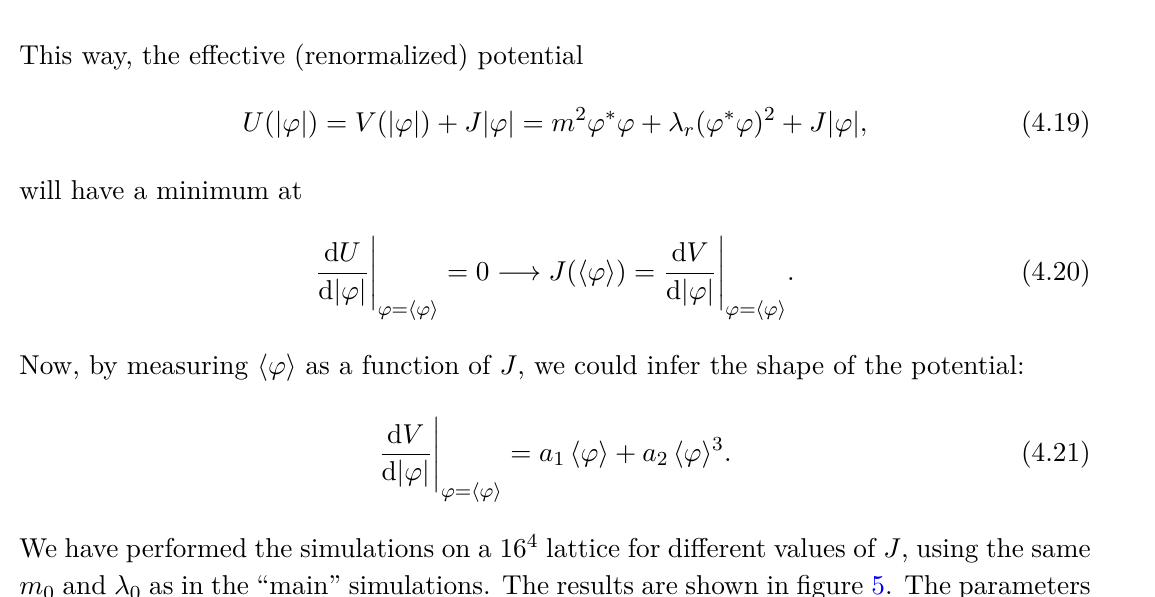
Table 1. Summary of simulations used in this work. T = 48 is kept throughout. n conf labels the number of field configurations. The number of updates per thread, ud/thr, is provided as well. In order to decrease correlation, only every 1000 th configuration is